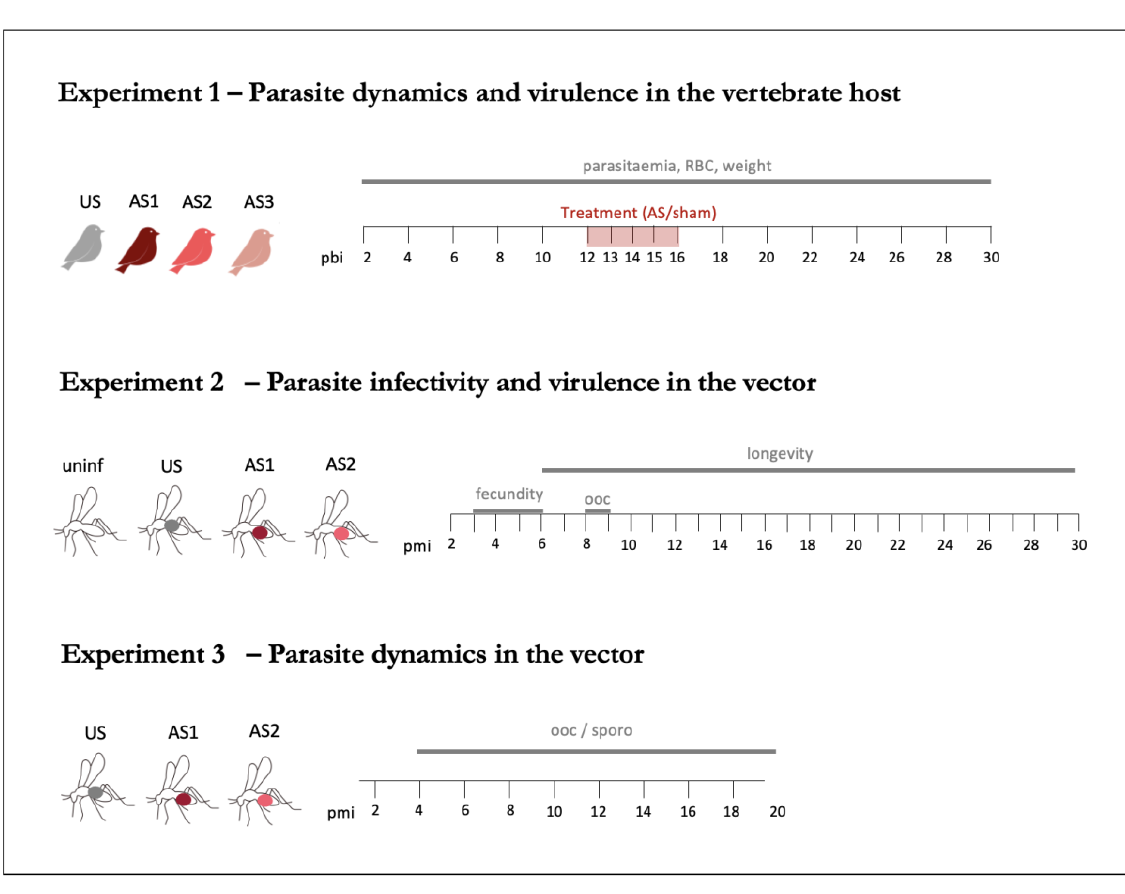
Figure 1: Experimental design for experiments 1 - 3. In Experiment 1 (n= 6 birds per line), samples were taken every two days between day 2 and day 30 post bird inoculation (pbi), except during the treatment course where samples were taken daily. The parameters quantified were: bird parasitaemia, bird weight and RBC count. In Experiment 2 (n = 2 birds per line plus 2 uninfecteed birds) we quantified fecundity (4-7 pmi, ~30 mosquitoes per bird per line), longevity (~150 mosquitoes per bird per line, survival was monitored on a daily basis), and oocyst count (8-9 pmi, 20 mosquitoes per bird). In Experiment 3 (n = 3 birds per line) : we dissected mosquitoes every two days (2-20 pmi) and quantified oocysts (microscopic examination of the midgut) and sporozoites (qPCR of the thorax). pbi = days post bird infection, pmi = days post mosquito infection. US = unselected reference line, AS1, AS2, AS3 = artesunate-treated (putatively resistant)